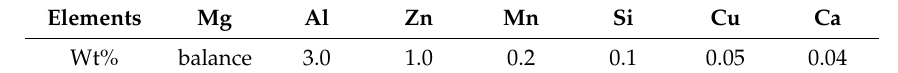
Table 1. Chemical composition of magnesium alloy AZ31B.